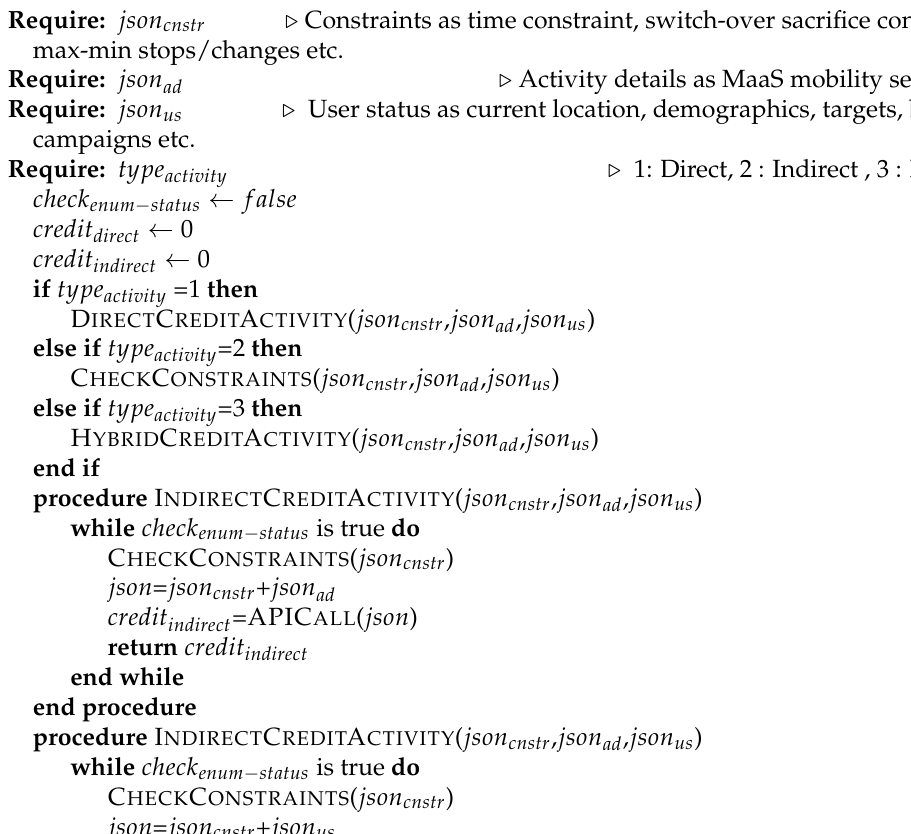
Algorithm 1 Activity Recommender